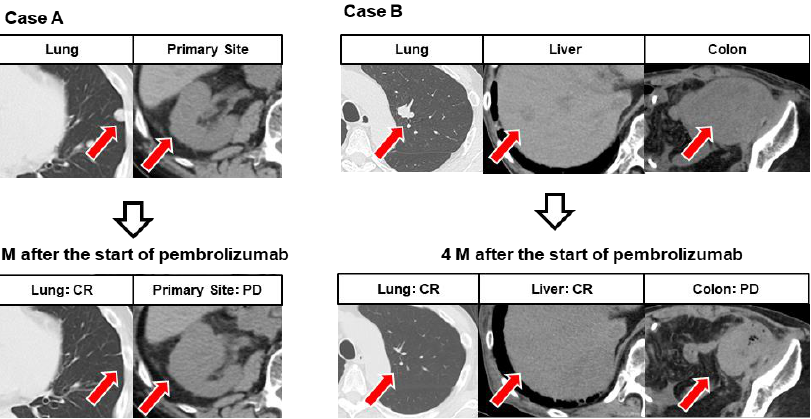
Figure 4. Representative images showing mixed response (MR) in different organs. Case ( A ): After six courses of pembrolizumab, the left lung metastasis had completely disappeared, but the primary lesion of the right renal pelvis showed progression. Case ( B ): After five courses of pembrolizumab, left lung metastases and liver metastases had completely disappeared, while colonic metastases showed